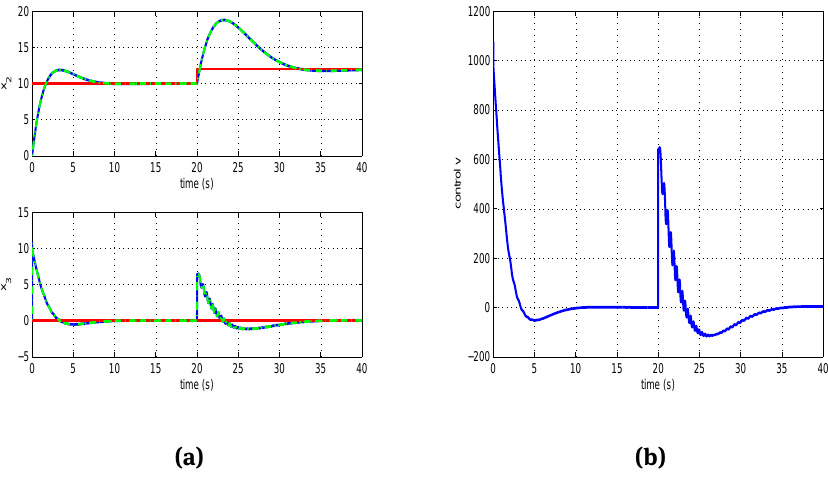
Fig. 4: Setpoint 2: (a) Convergence of the state variables of the SRM x 2 = ω , x 3 = ˙ ω (blue line: real value, green line: estimate value) by the H-infinity filter) to the associated reference values (red line). (b) Control input v applied to the control system of the